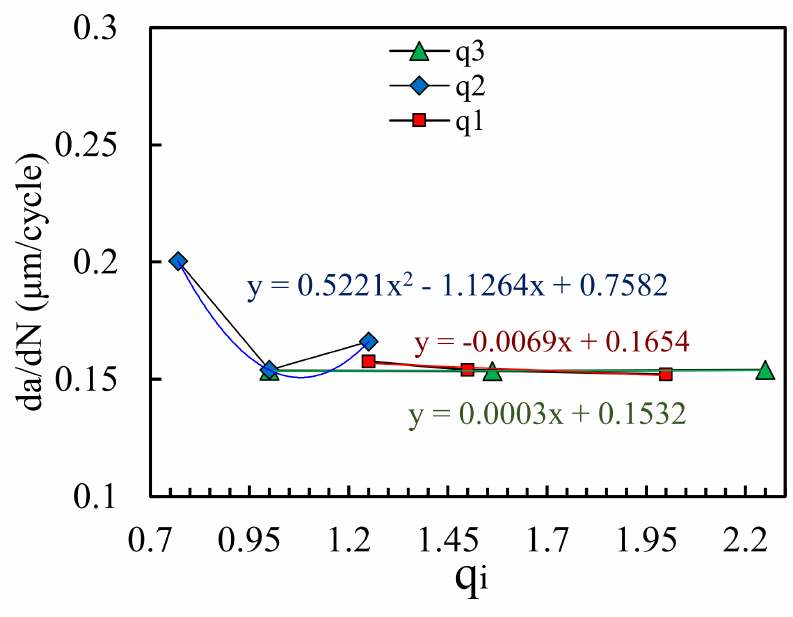
Figure 8. da/dN in terms of each Tvergaard parameter for a 0 = 11.5 mm. Results are shown in natural scales. Nucleation and coalescence are disabled. When q 1 is changed: q 2 = 1 and q 3 = 2.25. When q 2 is changed: q 1 = 1.5 and q 3 = 2.25. When q 3 is changed: q 1 = 1.5 and q 2 = 1. ( f 0 = 0.01).